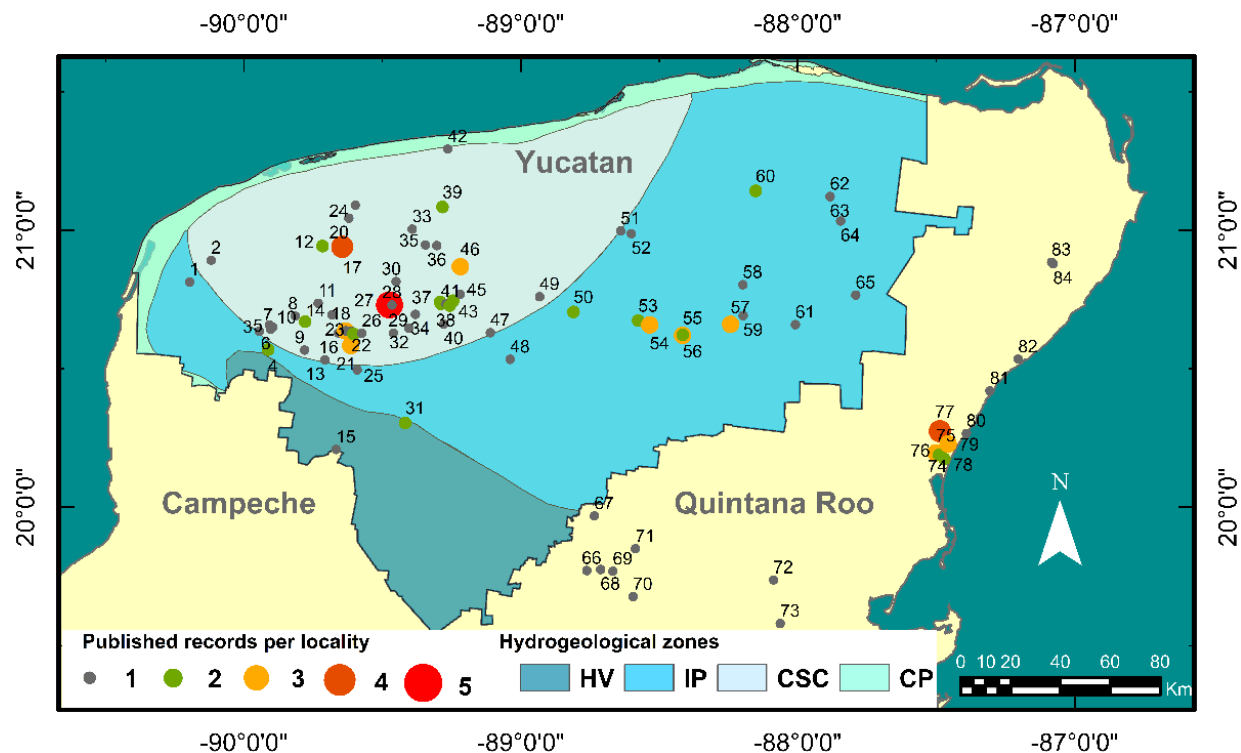
Figure 5. Known locations (dots) where at least one individual of A. cenotensis was previously reported in literature and/or scientific collections. Number of records/occurrences over time per location (dot color and size). Hills and valleys (HV), interior plain (IP), cenote semi-circle (CSC), and coastal plain (CP) hydrogeological zones in the state of Yucatan. Location name is presented along with the municipality where it is found (between parentheses) for each state (italics). Yucatán: (1) Noh Chucunchey (Celestún); (2) well (Kinchil); (3) Calchum (Kopomá); (4) well (Calcehtok); (5) Cenote de las Abejas (Kopomá); (6) San Bulhá (Kopomá); (7) San Tito (Kopomá); (8) Pool Box (Chocholá); (9) Cenote del Pochote (Opichén); (10) Dzonbakal (Chocholá); (11) Bebelchén (Sanahcat);